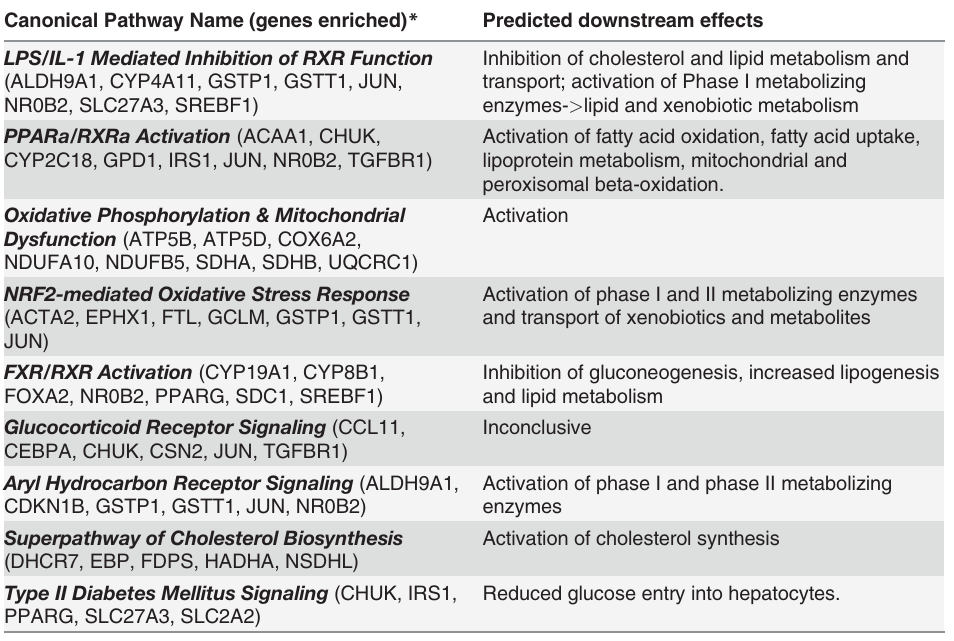
Table 3. Topmost 10 canonical pathway enrichments at 4 wks post-stressor. Canonical Pathway Name (genes enriched)